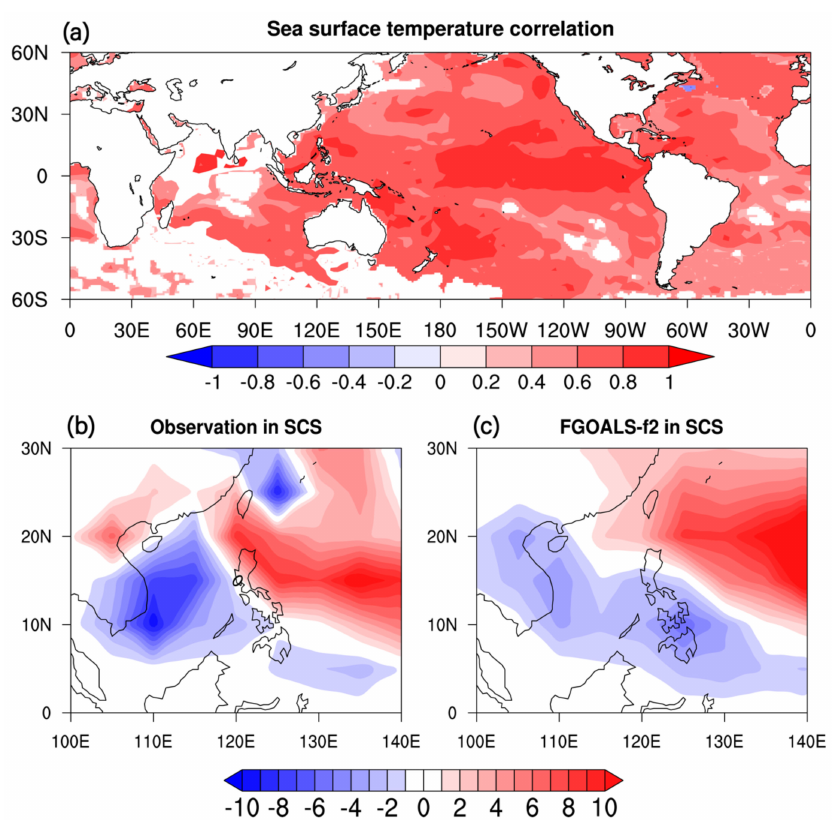
Figure 5. The correlation coefficients of global SST between the hindcast of FGOALS-f2 and OISSTv2 from July to November during 1981 to 2015 ( a ) at the 95% confidence level. In addition, the seasonal mean (July to November) track density of TC between El Niño and La Niña years for OISSTv2 ( b ) and the hindcast of FGOALS-f2 ( c ) in SCS are also given. Blue (red) anomalies show a negative (positive) El Niño